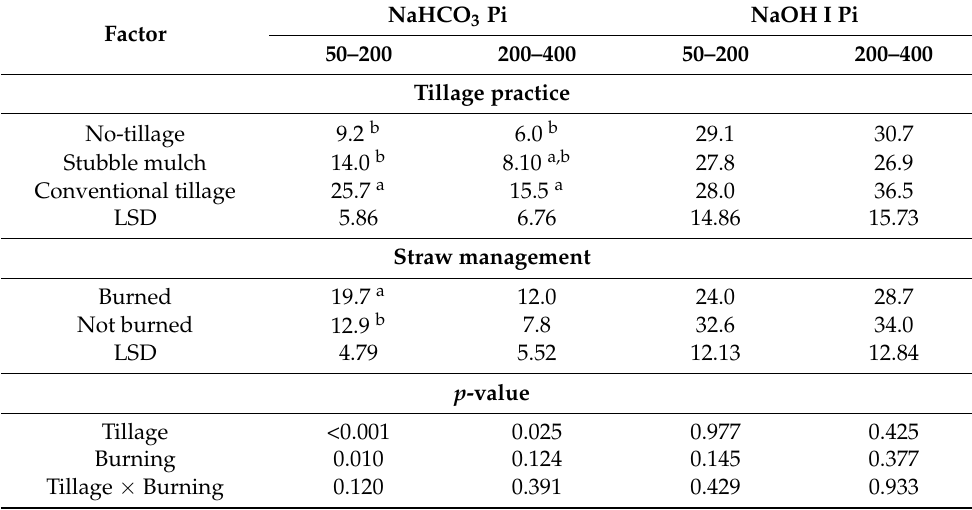
Table 5. The effects of tillage and straw management on soil NaHCO 3 Pi and NaOH I Pi (mg kg − 1 ) in the 50–200 and 200–400 mm layers.